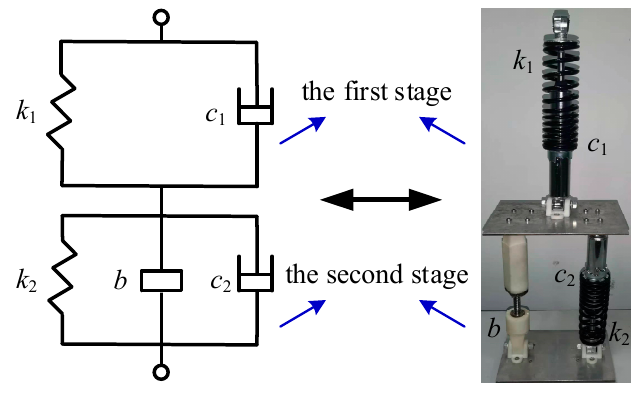
Figure 2. ISD damping module.